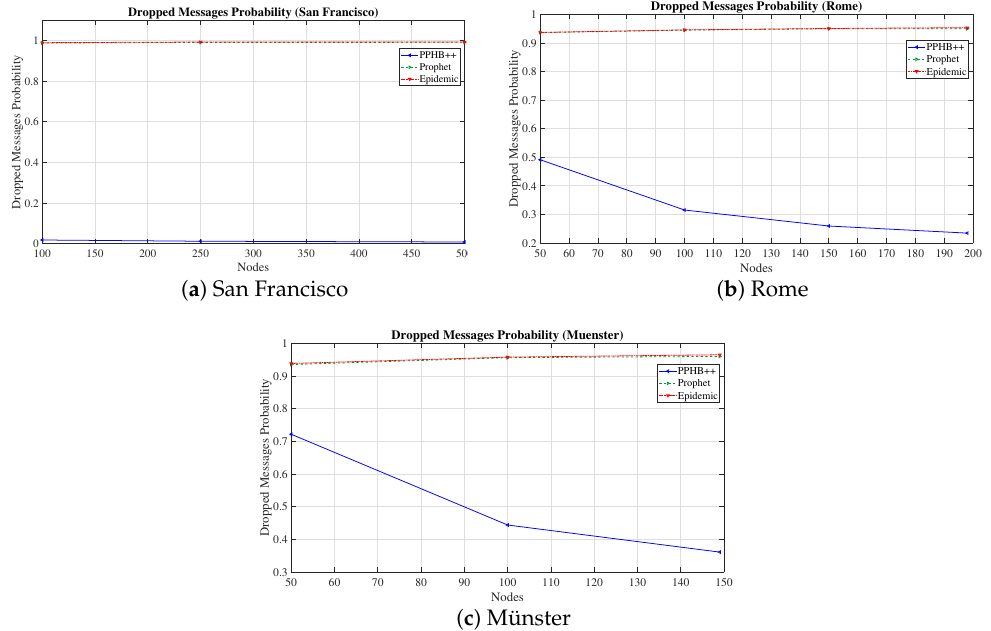
Figure 4. Dropped message probability (DMP) for the three cities of San Francisco, Rome, and Münster (The y-axis parameter is normalized to a scale between 0 and